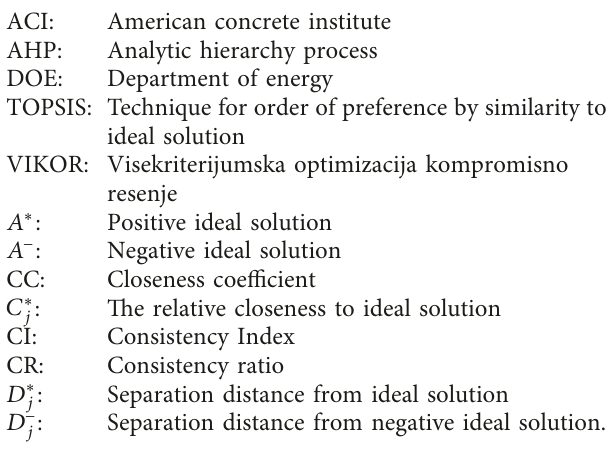
Table A2: pairwise comparison of subcriteria (mix factors) with workability criteria (performance). Table A3: pairwise